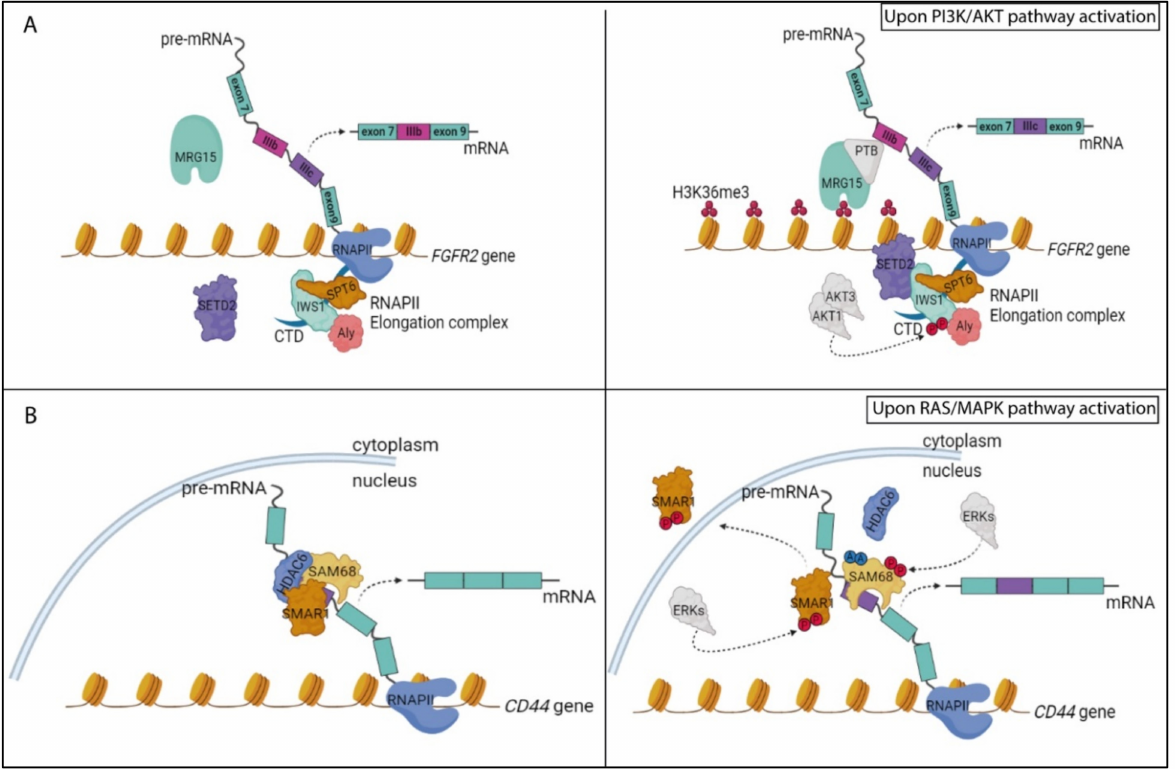
Figure 2. Examples of signaling-dependent regulation of alternative splicing. ( A ) The two alternatively spliced isoforms of FGFR-2 comprise one of the two mutually exclusive exons IIIb and IIIc. In healthy cells, FGFR-2 mature mRNA mainly contains the variable exon IIIb. However, AKT1/3-mediated phosphorylation of IWS1 in lung carcinoma cells favors the recruitment of the histone H3K36 methyl transferase SETD2 to the carboxyl-terminal domain (CTD) of RNA polymerase II (RNAPII). SPT6 and Aly are part of the RNAPII elongation complex together with IWS1. SETD2-dependent trimethylation of H3K36 (H3K36me3) of exon IIIb promotes the recruitment of the chromatin-binding protein MRG15 and of the splicing factor PTBP1, which repress the inclusion of exon IIIb in the mature transcript and lead to splicing of exon IIIc. ( B ) In healthy cells, SMAR1 is located in the nucleus and is part of an RNA-dependent trimeric complex together with Sam68 and HDAC6. The complex is bound to alternative exons (in purple) of CD44 pre-mRNA, thus repressing their inclusion into the mature CD44 mRNA. In breast tumor cells, activation of the RAS/MAPK pathway results in ERK1/2-dependent phosphorylation of SMAR1 and Sam68, leading to the translocation of the nuclear protein SMAR1 into the cytoplasm, the release of HDAC6 into the nucleoplasm, and the acetylation of Sam68. In turn, acetylation and phosphorylation of Sam68 induces its splicing activity and promotes the inclusion of the alternative exons into the mature CD44